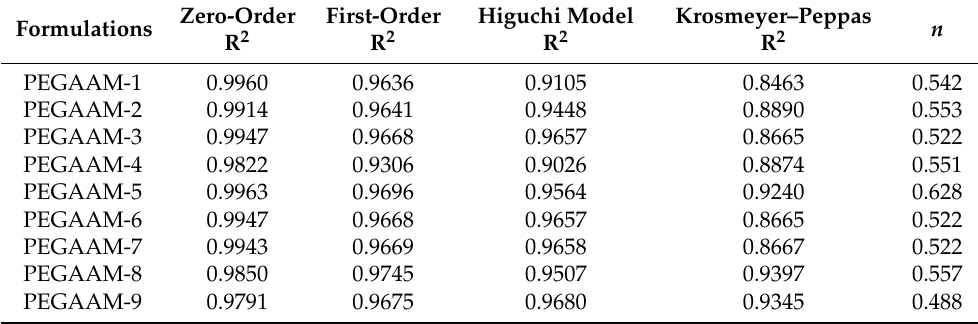
Table 5. Kinetic modeling on bacitracin zinc-loaded topical patch.